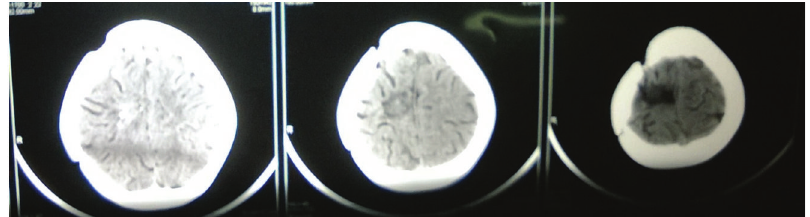
Figure 12: CT scan brain with residual tumor in the right temporoparietal region May